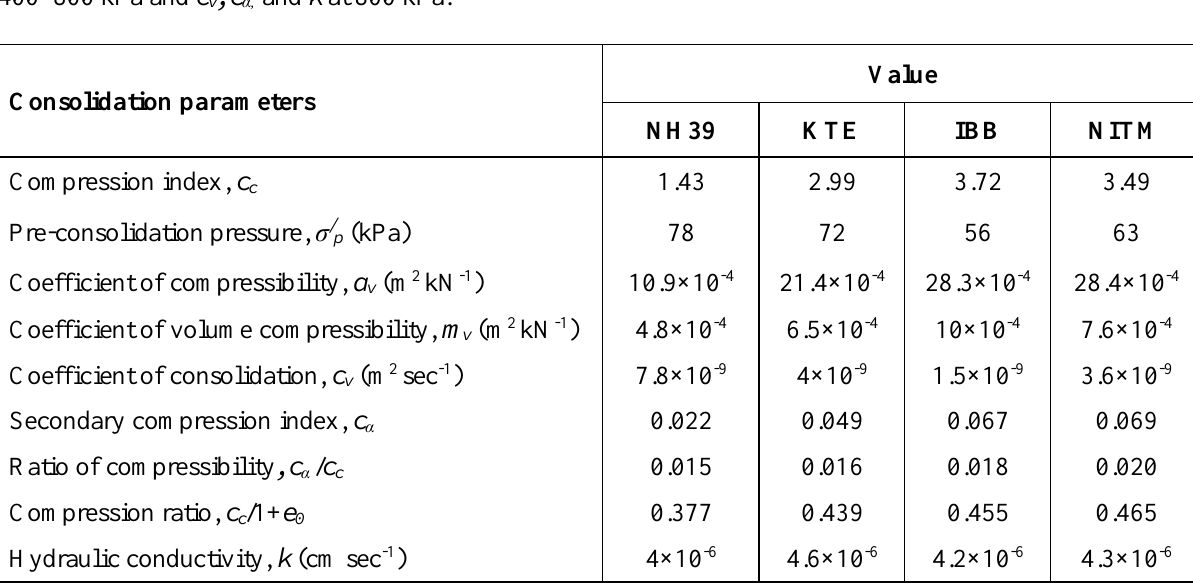
Table 5. Consolidation parameters of Northeast Indian peats. Note that a v and m v are calculated at stress level 400–800 kPa and c v , c α, and k at 800